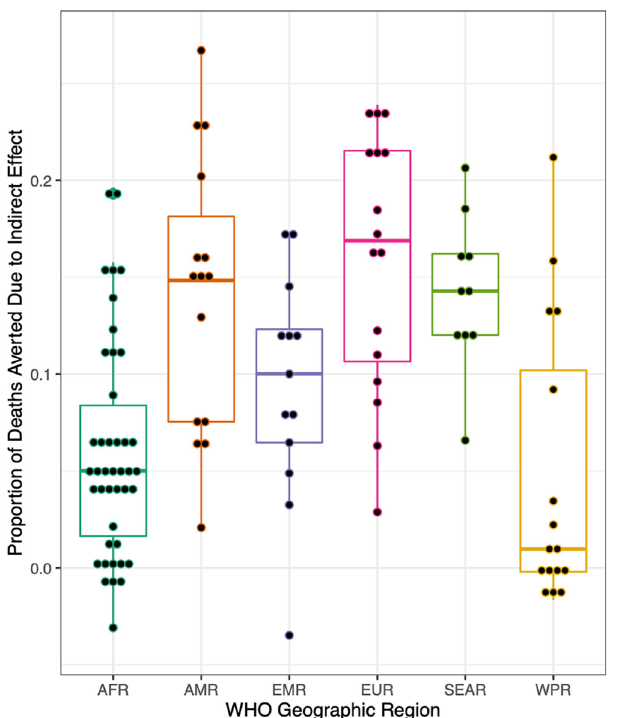
Fig. 2 Distribution of country-level indirect effect values at 8 years post-vaccine introduction, grouped by WHO geographic region. In the boxplot below, the center line indicates the median and the lower and upper boundaries of the box represent the fi rst and third quartile (Q1 and Q3), respectively, such that the box covers the inter-quartile range (IQR) for each region. The lower whisker is the predicted minimum value by region (Q1 – 1.5 x IQR) and the upper whisker is the predicted maximum value (Q3 + 1.5 x IQR) by region. Each country level estimate is shown as a point in the plot below. Dots above and below the whiskers are